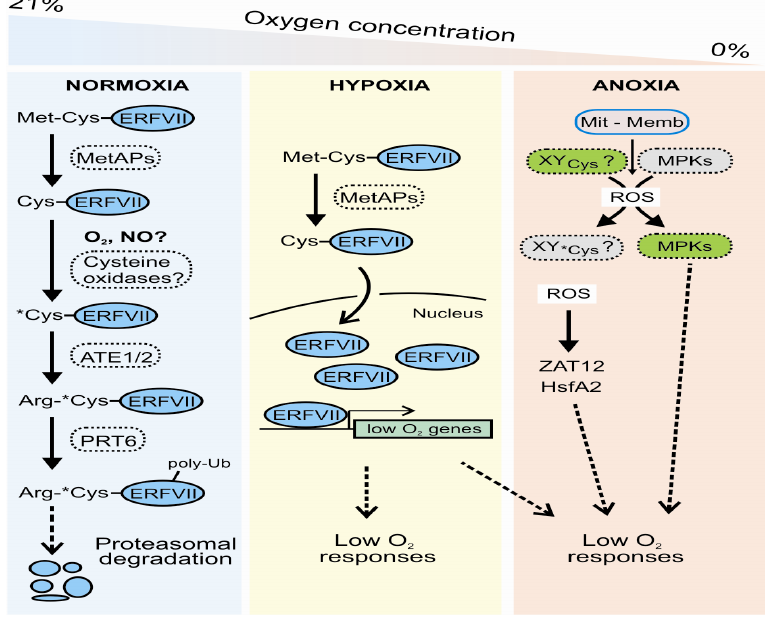
Figure 2. Low oxygen sensing mechanisms in plants are mediated by the N -end rule pathway and ROS. Group VII ERF transcription factors bear a conserved Met-Cys N -degron that, under normoxia, targets them to constitutive proteasomal degradation, through a branch of the N -end rule pathway that relies on the production of oxydized cysteine ( * Cys) as an intermediate. Oxygen limiting conditions lead, instead, to stabilization of the Met-Cys N -degron, thereby allowing ERFVII to migrate into the nucleus and activate transcription of low oxygen-responsive genes. Low oxygen responses under anoxia also depend on the accumulation of reactive oxygen species (ROS), which triggers the accumulation of ROS-responsive transcription factors and may regulate cysteine-containing enzymes, contributing to the activation of MPKs. This triggers a signaling cascade leading to enhanced plant tolerance. Abbreviations: MetAPs, Met-aminopeptidases; ATE1/2,